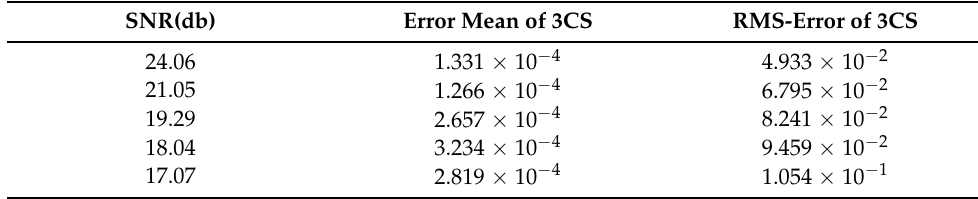
Table 4. The 3CS method error at different levels of noise